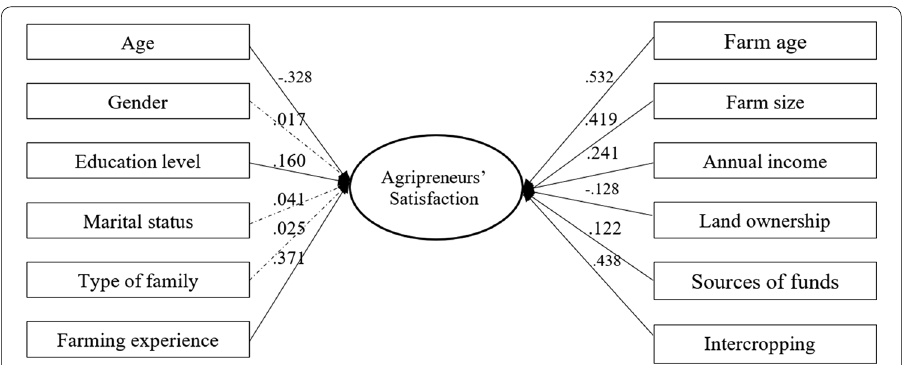
Fig. 3 Regression model for effect of demographics and emporographics on agripreneurs’